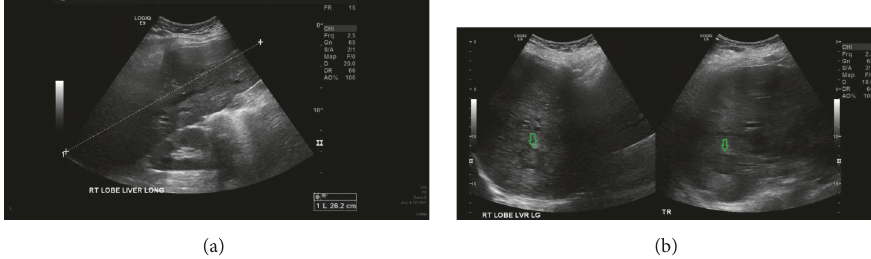
Figure 1: Liver ultrasound. (a) demonstrates the size of the liver measured to be about 26.2 cm. (b) demonstrates the hypoechoic mass in the right hepatic lobe (green arrows). The mass measured 2.8 cm.